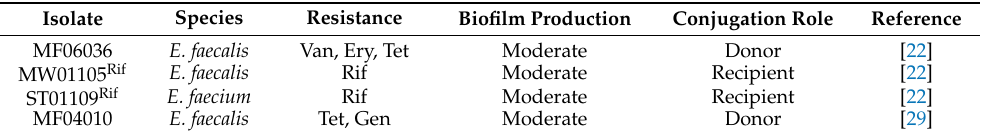
Table 1. Bacterial strain